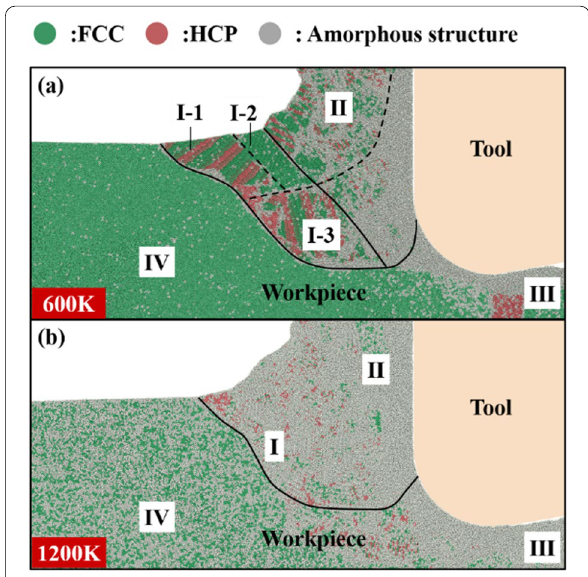
Fig. 7 Crystal structure distribution of chip root, a 600 K, b 1200 K